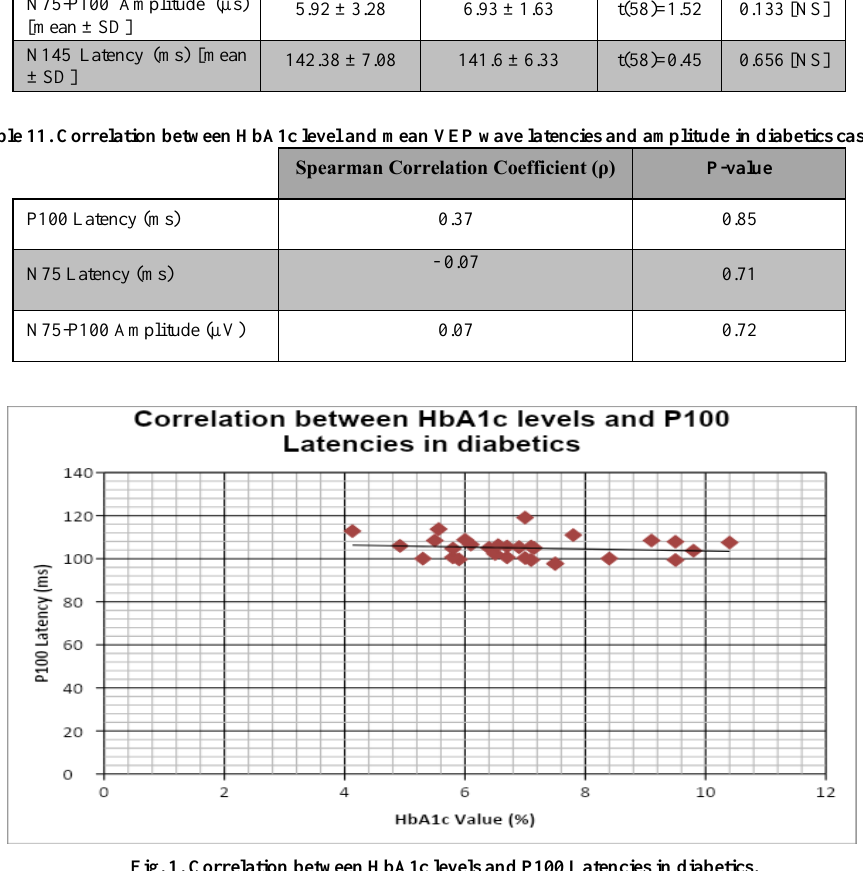
Fig. 1. Correlation between HbA1c levels and P100 Latencies in